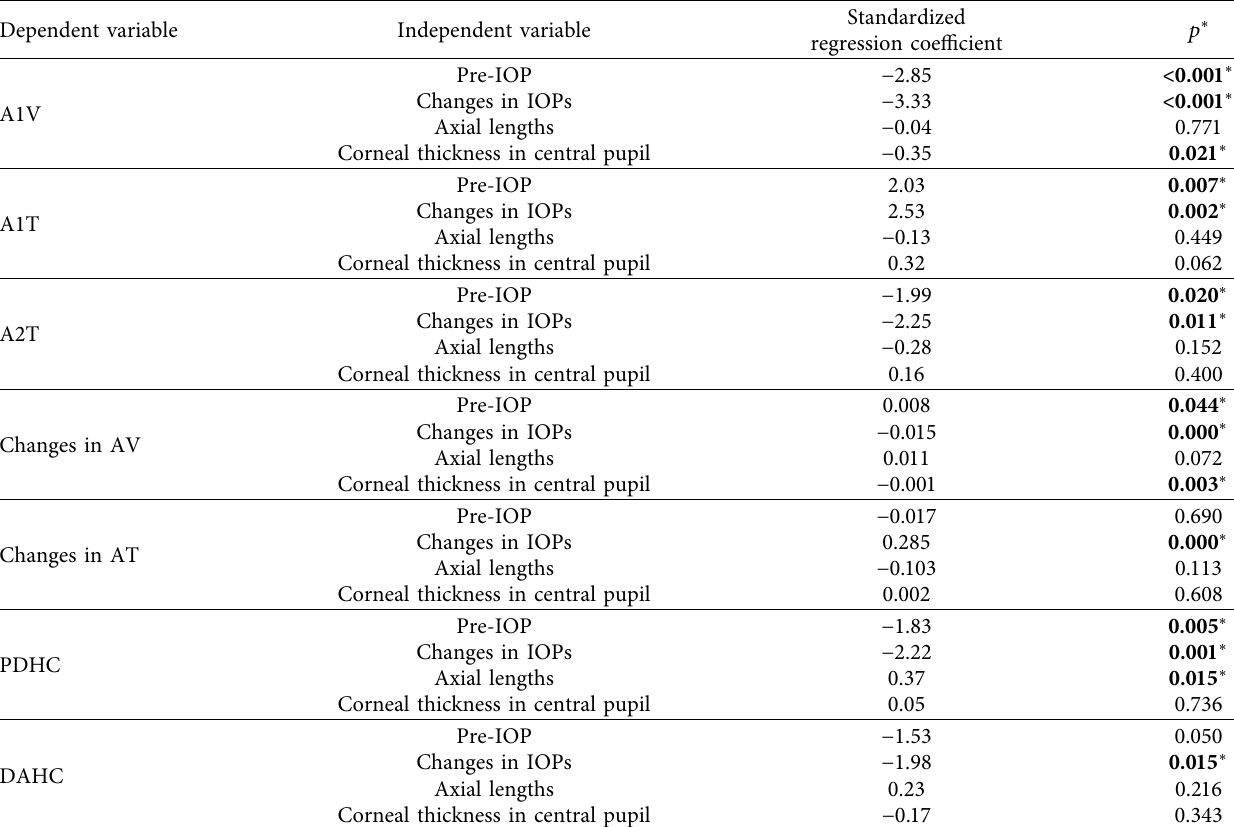
Table 4: Multiple line regression analysis associated factors for signifcant Corvis ST